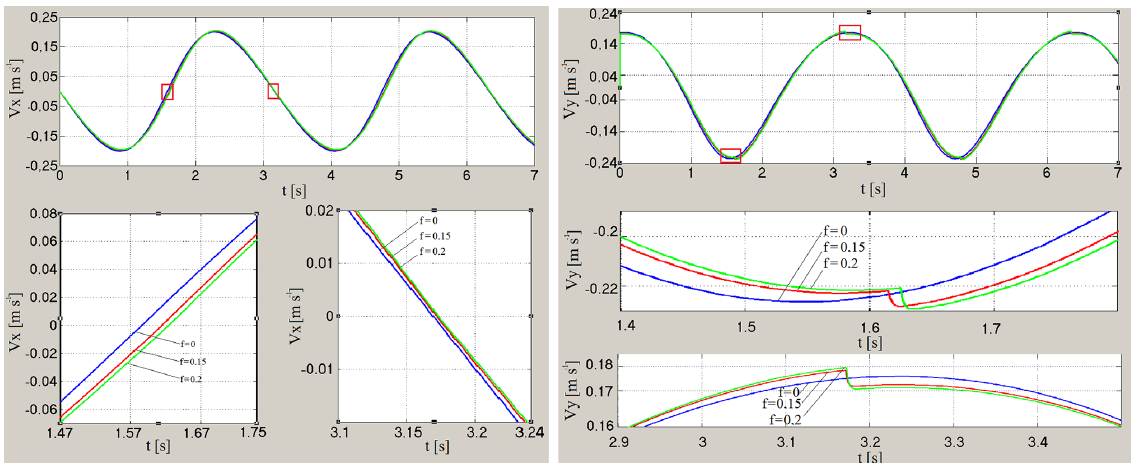
Figure 16. Graphs of velocity projections V x ( t ) and Vy ( t ) of point C for different values of the coefficient of sliding friction f and for coefficient of rotational friction k = 0 and for load mass M =